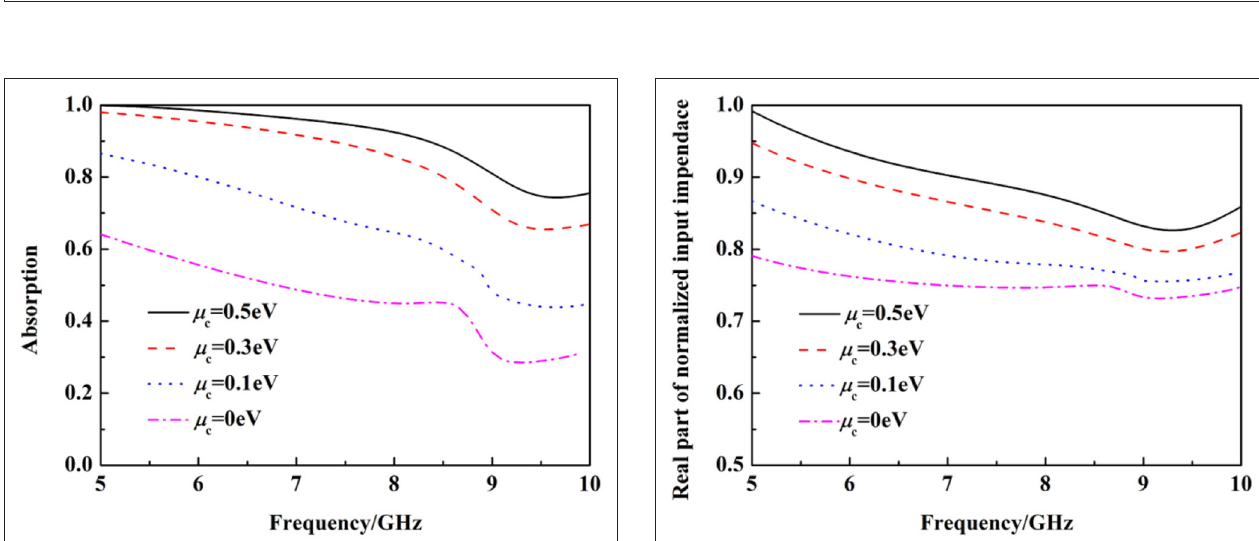
Frontiers in Physics | www.frontiersin.org